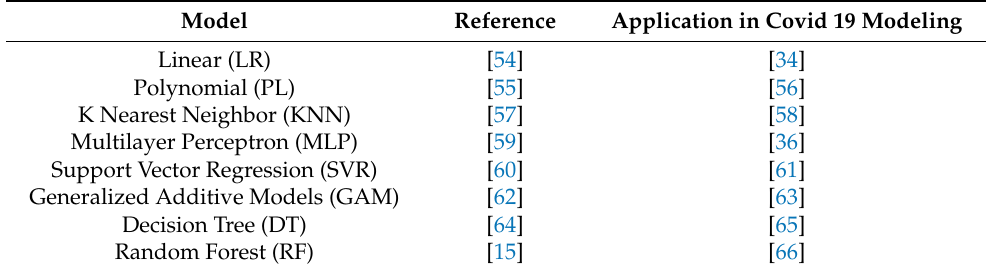
Table 2. Regression models applied to predicting the number of active